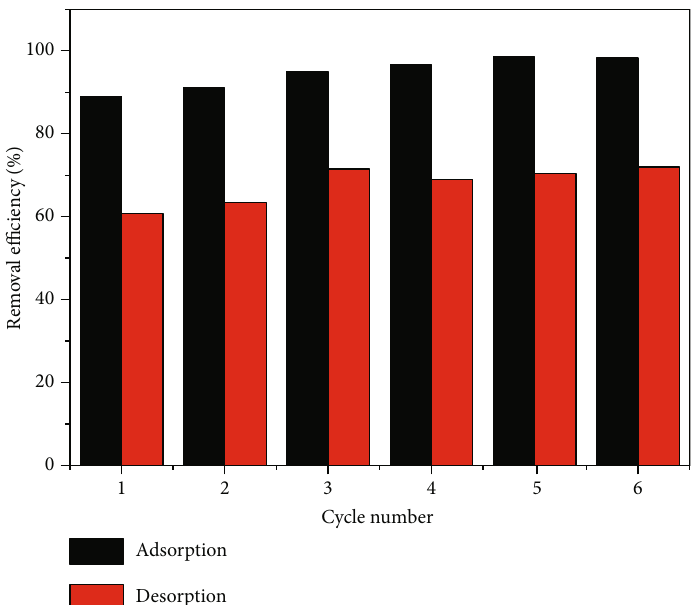
Figure 14: Desorption-regeneration cycles. (Absorbent dosaging, 400 mg/L; pH value, 3.0; initial concentration, 10mg/L; temperature, 298.15K; contact time, 90min; rpm,